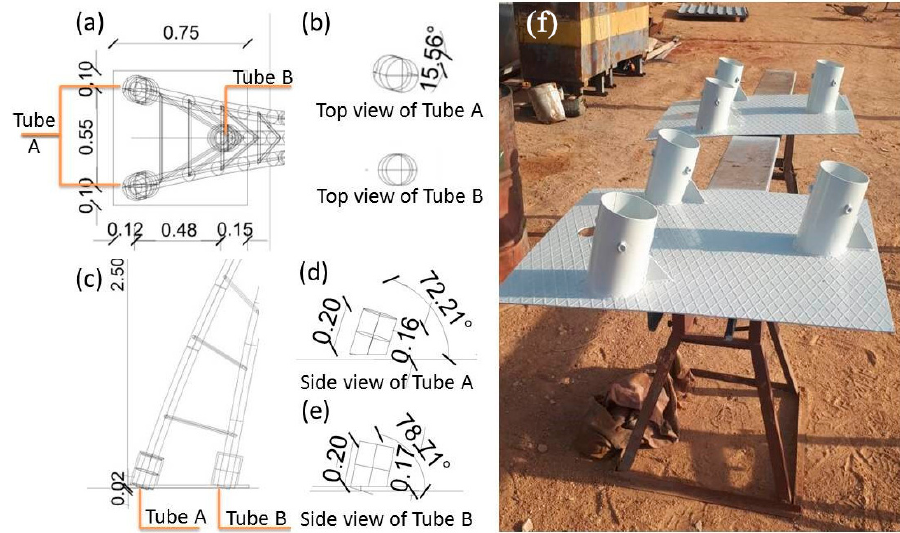
Figure 9. The prefabricated base. ( a ) Top Dimensions of the stainless steel base. ( b ) Horizontal angle of rotation of the tubes ( c ) Side view of the base. ( d ) Vertical angle of inclination of Tube A. ( e ) Vertical angle of inclination of Tube B. ( f )The base after completion.